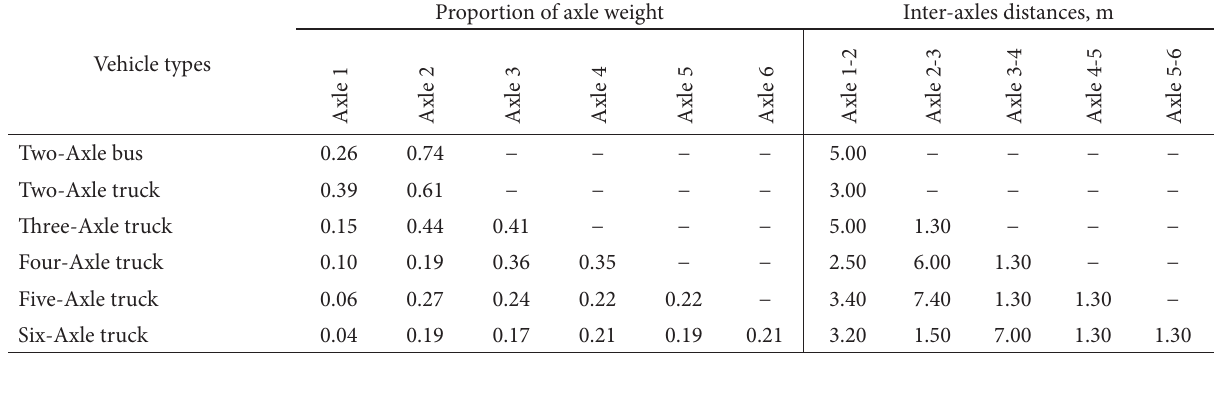
Table 5. Axle weight proportion and axle spacing of different kinds of vehicles